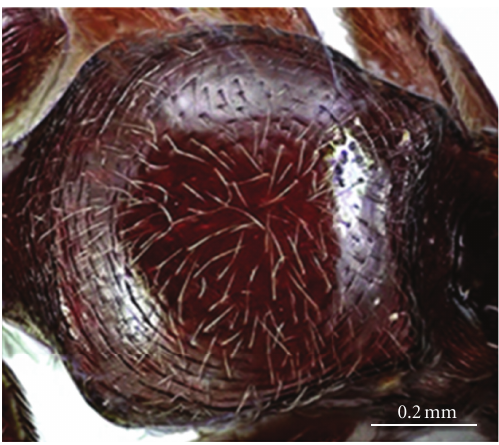
Figure 4: Tatuidris kapasi : holotype worker. Mesosoma: dorsal